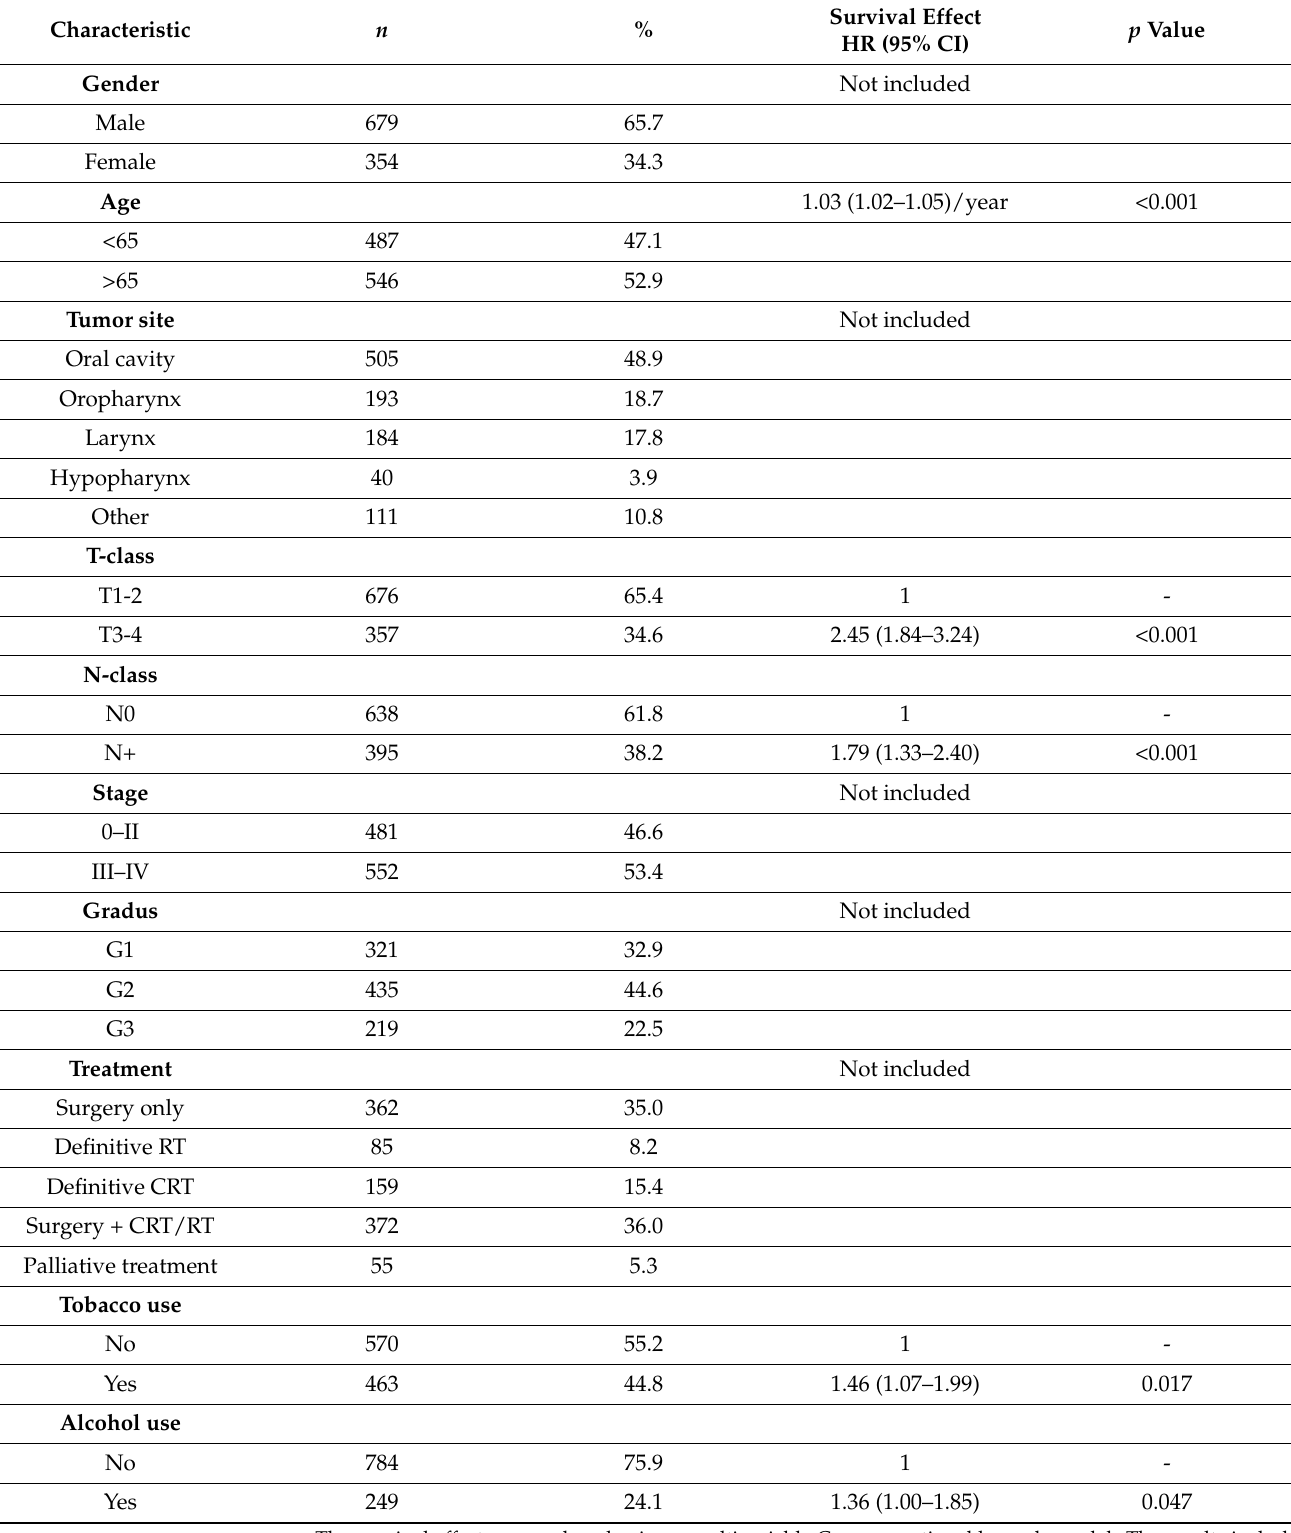
Table 1. Patient characteristics. RT (radiotherapy), CRT